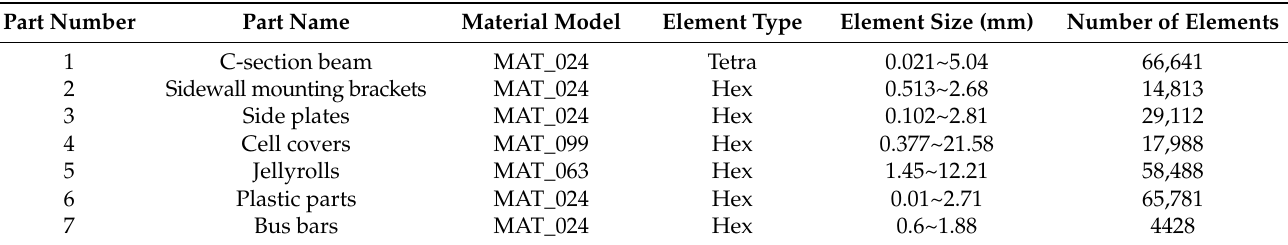
Figure 3. FE model of the battery module with wedge indenter and base support. Table 2. Details of the FE model used for individual parts.